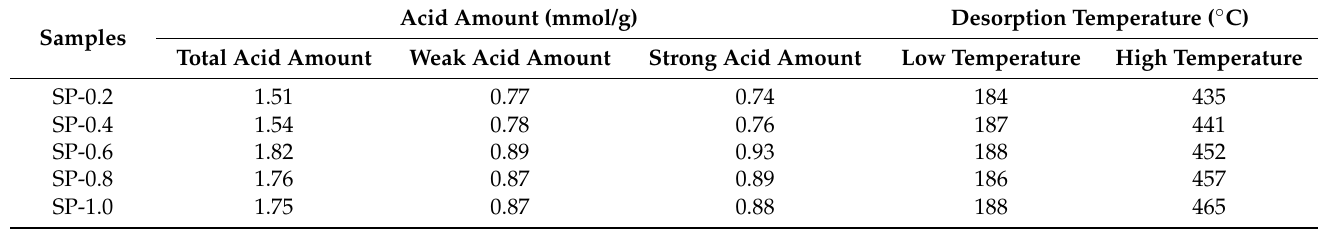
Table 3. The amount of acid sites of as-synthesized samples.